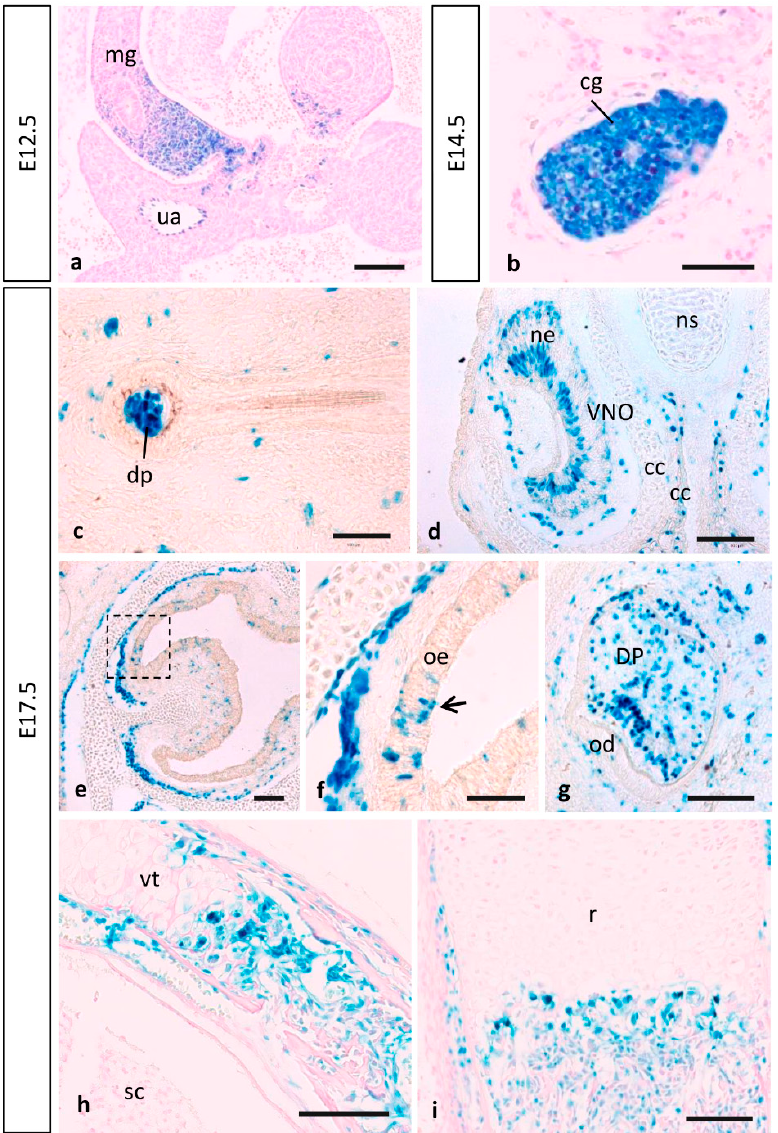
Figure 9. MT1-MMP expression in other mouse embryonic structures. Reporter expression in Mt1- mmp LacZ/+ early embryos was detected in the midgut loop and the cervical sensory ganglia. At E17.5, β -gal positive cells localized in the dermal papilla of the hair follicle ( c ), in sensory neurons of the vomeronasal organ ( d ) and the olfactory epithelium ( e , f ), and also in the condensing dental mesenchyme. Notably, MT1-MMP expression was also detected during endochondral ossification in the vertebra ( h ) and the radius of the hindlimb ( i ) by this stage. Abbreviations: cc, cartilaginous capsule; cg, cervical sensory ganglia; dp, dermal papillae; DP, dental pulp; mg, midgut loop; ne, neurosen- sory epithelium; ns, nasal septum; od, odontoblast; oe, olfactory epithelium; r, radius; sc, spinal cord; ua, umbilical artery; VNO, vomeronasal organ; vt, vertebra. Scale bars: 100 mm ( a , d , e , g – i ), 50 mm ( b , c , f ).